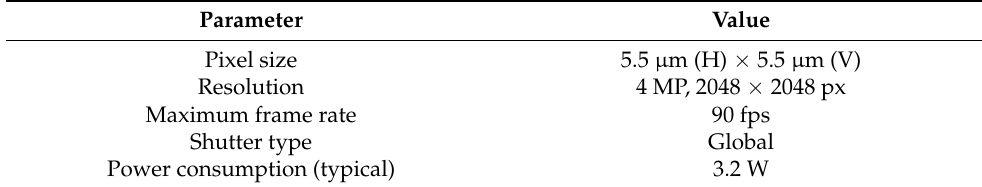
Table 3. Main features of the selected CMOS sensor for HORUS payload.